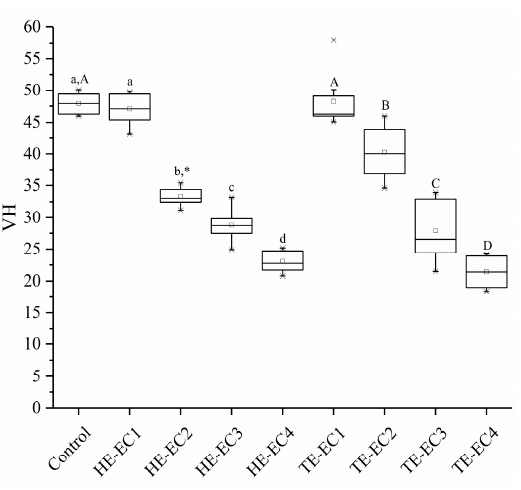
Figure 1. Surface hardness (VH) mean values of experimental composite resins. The same lower letters indicate that there is no significant difference in surface hardness between experimental composite resins with different weight fractions of HE-Phene in the resin matrix. The same upper letters indicate that there is no significant difference in surface hardness between experimental composite resins with different weight fractions of TE-Phene in the resin matrix. The asterisk * indicates the statistical differences between composites with different Phene like monomers at the same mass fraction in the resin matrix.